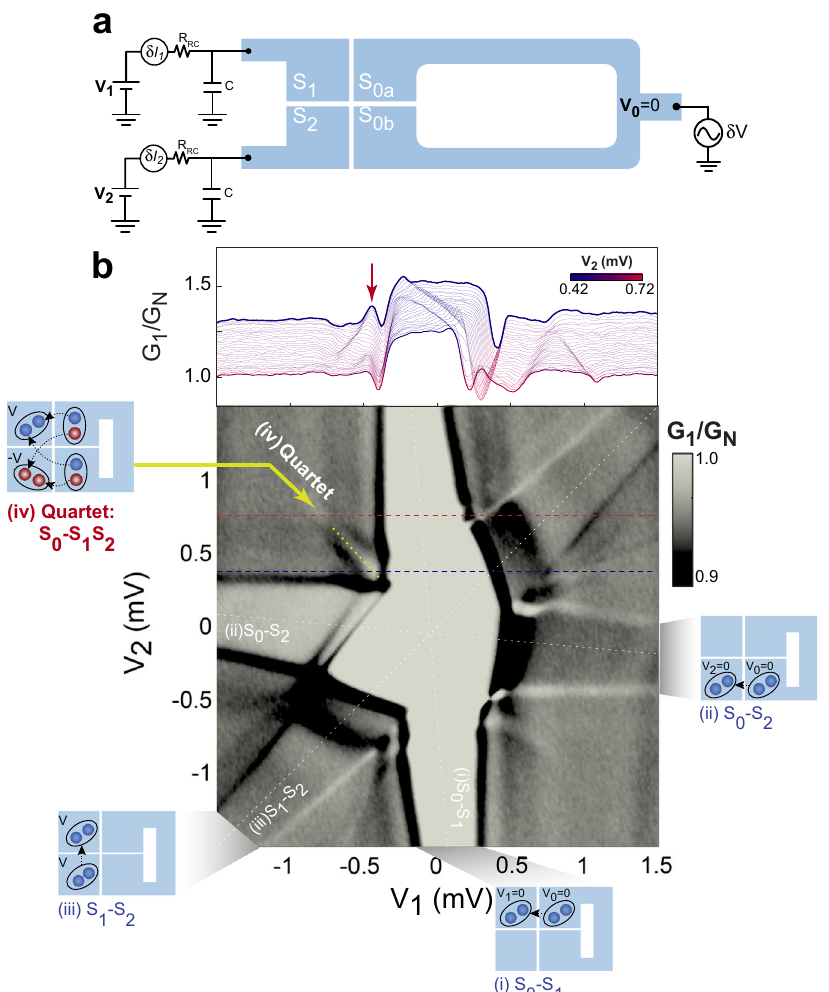
Fig. 2 Dual source voltage bias characterization for quartet detection. a Con fi guration for the quartet measurement. The loop S 0 is grounded while potential of the fi rst ( S 1 ) and second ( S 2 ) electrodes are controlled via DC voltages V 1 and V 2 , respectively. An additional AC excitation δ V is applied to the loop, and the AC current δ I 1 ( δ I 2 ) through S 1 ( S 2 ) is measured. b top panel: differential conductance G 1 ( = δ I 1 = δ V ) measured at S 1 as a function of the DC bias voltage V 1 when V 2 is tuned from 0.42 to 0.72 mV. Bottom panel: color plot of G 1 as a function of V 1 and V 2 (excluding the circuit resistance R RC ), with V bg ¼ 40V. In total, there are four different supercurrents in the device. Inset (i) – (iii) show the local Josephson supercurrent between any pair of leads at the same potential. Inset (iv) Quartet shows the non-local quartet supercurrent fl owing among all three superconducting leads and the quartet signal in ( V 1 , V 2 )- plane is the narrow yellow region along the − 45 degree direction (where the red arrow points